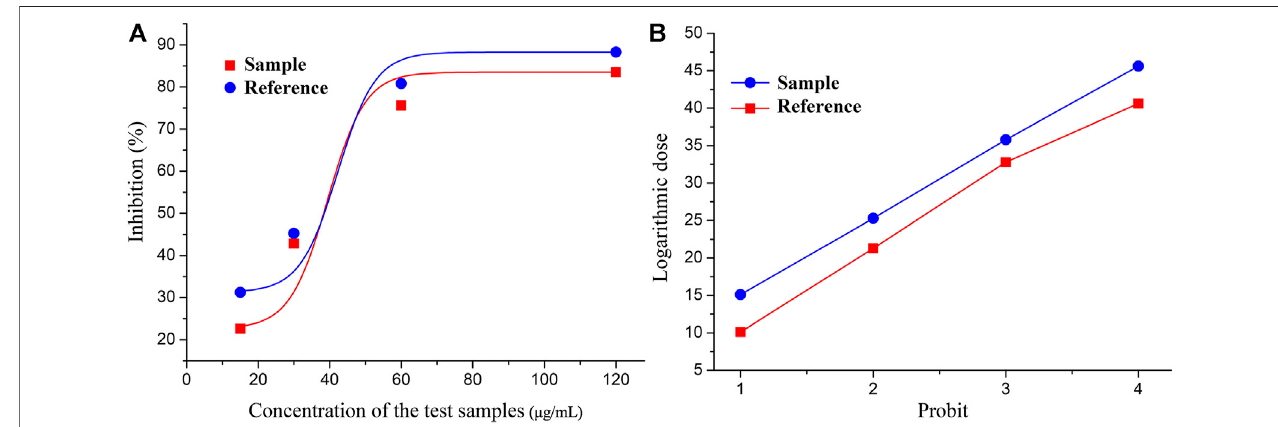
FIGURE 2 | Coordinate transformation of qualitative response: (A) The relationship between the concentration of tested drugs and inhibition rate. (B) The relationship between logarithmic doses and